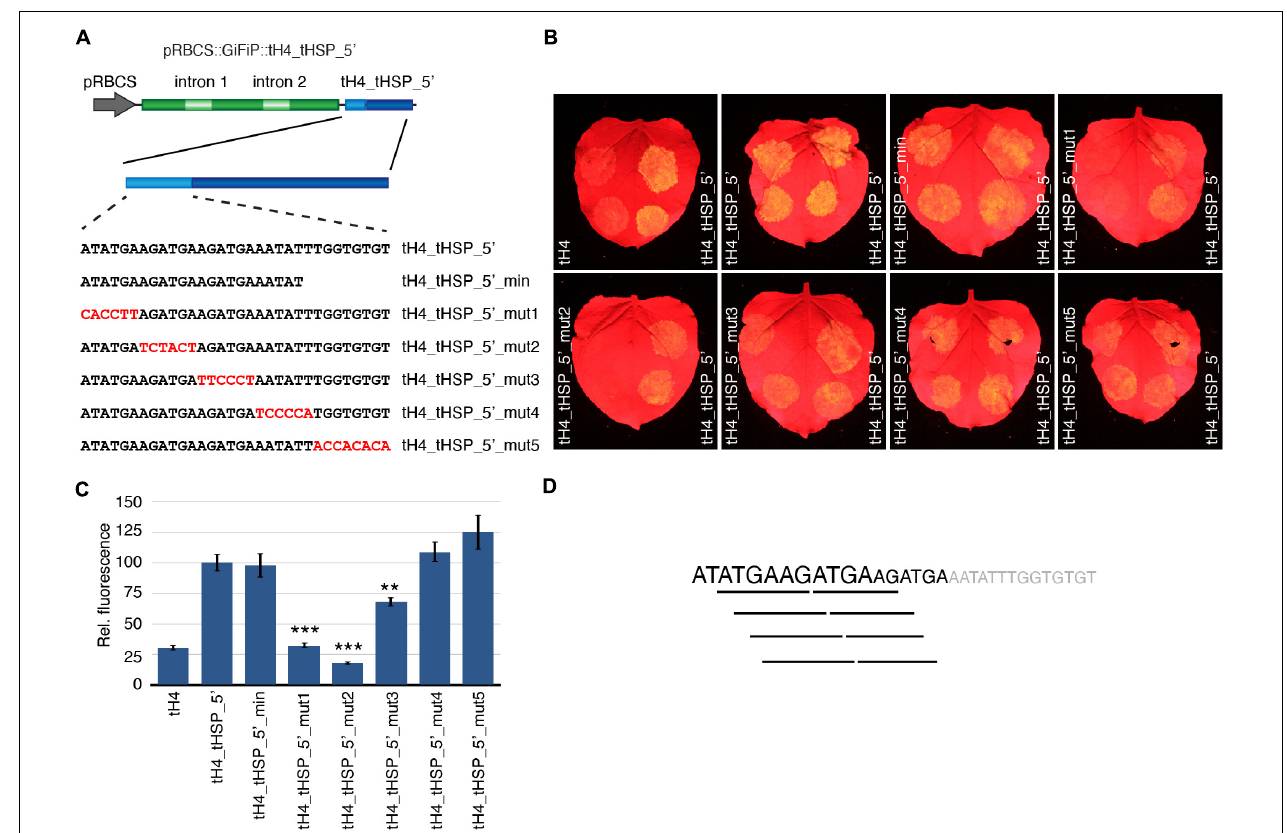
FIGURE 5 | Characterization of tHSP 5 (cid:48) region. (A) Constructs designed to identify sequence elements contributing to the positive effect exhibited by the tHSP 5 (cid:48) end. Representative GFP phenotypes (B) and the relative levels of fluorescence (C) of 10 infiltration spots are given (replicates collected from five leaves, one leaf per plant). Mutations resulting in statistically significant changes in fluorescence when compared to tH4_tHSP_5 (cid:48) are marked with a “**” or “***” ( p ≤ 0.01 and p ≤ 0.001, respectively; Mann-Whitney U test). (D) The tHSP 5 (cid:48) region. Sequences contributing to the improvement of gene expression are shown in black, with the degree of impact reflected in the size of the characters. Lines underneath the sequence highlight possible motifs presented in this